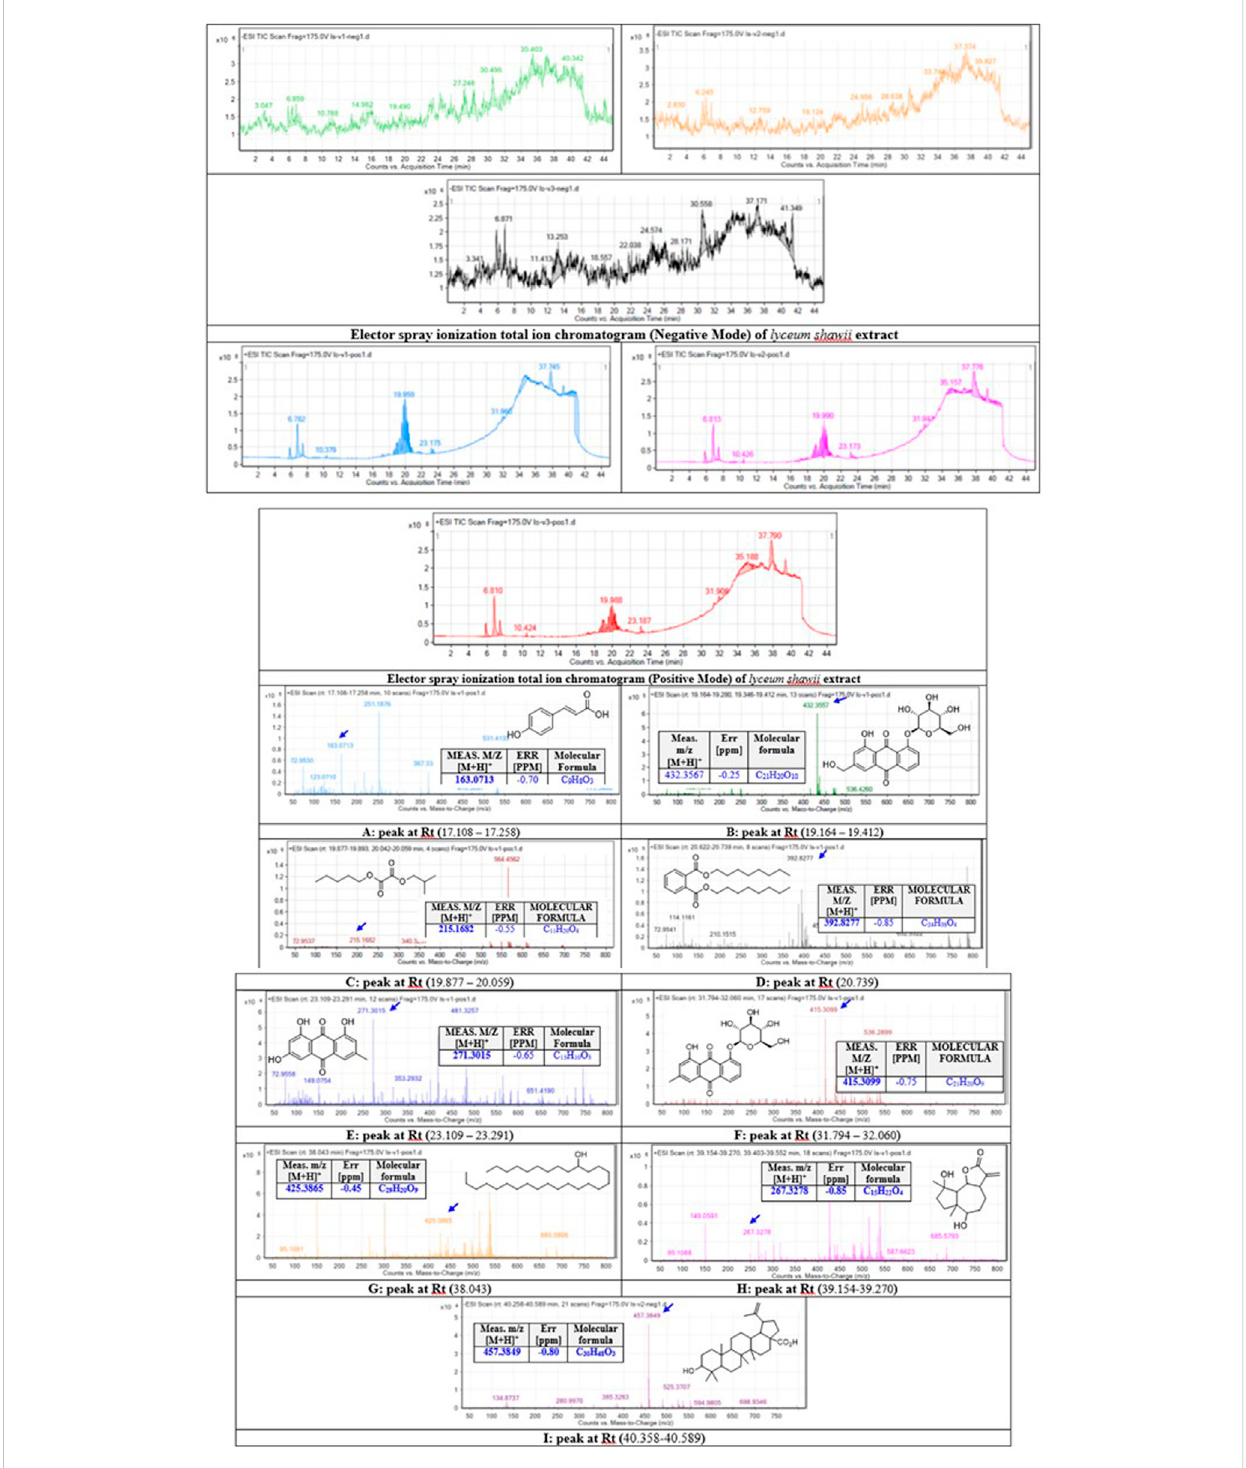
FIGURE 6 Base peak chromatograms of the L. shawii methanolic extract were extracted, and tentatively identi fi ed secondary metabolites are as follows: P-coumaric acid (4-hydroxycinnamic acid) (Pei et al., 2016) (A), aloe-emodin (Rehman et al., 2018) (B), oxalic acid isobutyl pentyl ester (2-methylpropyl pentyl ethanedioate) (Singariya et al., 2015) (C), di-n-octyl phthalate (dioctyl 1,2 benzenedicarboxylate) (DeAngelo et al., 1986) (D) , apigenin (4,5,6- trihydroxy fl avone)(Shukla andGupta,2010) (E) ,chrysophanol-8-O- β -D-glucoside(Rehmanetal.,2016) (F) ,nonacosan-10-ol(Yaoetal.,2011) (G) , lyciumate (Rehman et al., 2019) (H) , betulinic acid (Yao et al., 2011) (I) , and m/z implies measured m/z